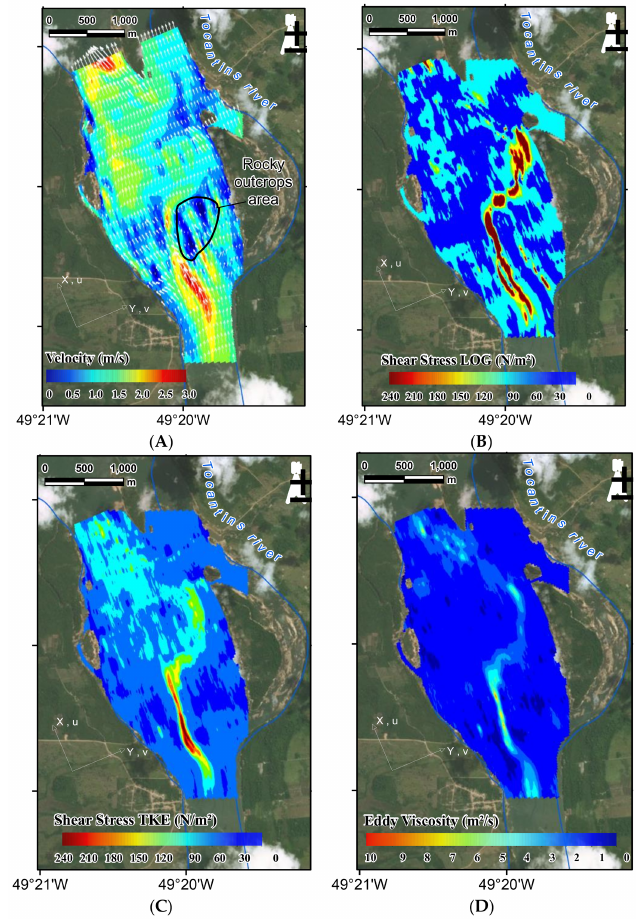
Figure 11. ( A ) Velocity magnitude and vector direction within the river section; ( B ) Shear stress distribution using the log method; ( C ) Shear stress distribution using the TKE method; ( D ) Eddy viscosity distribution based on the shear stress computed by TKE